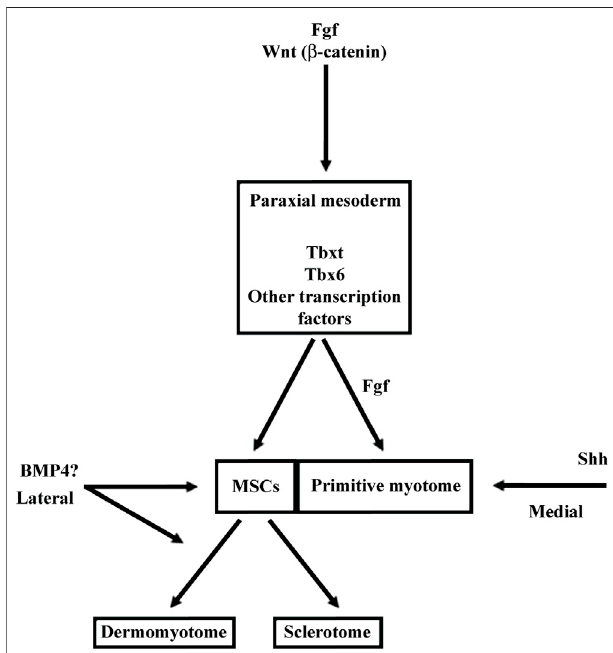
FIGURE 9 | The signaling pathways involved in MSCs and primitive myotome formation in Xenopus . In anamniotes and particularly in Xenopus , the somite development is characterized by the early and massive myotome formation, and the delayed sclerotome development. The construction ofprimitivemyotomeissoearlyspeci fi edthatitisinterconnectedtothedorso- mesoderm induction and the paraxial mesoderm speci fi cation. The signaling pathways like Fgf, Wnt and Nodal, involved in the dorso-mesoderm induction and in the paraxial mesoderm speci fi cation, also quickly trigger myogenic program leading to the primitive myotome formation (Jones et al., 1995; Wylie et al., 1996; Joseph and Melton, 1997; Fisher et al., 2002; Dorey and Amaya, 2010). In contrary, the amniote myotome formation takes place later after somitogenesis and the same signaling pathways involved earlier in the mesoderm induction and in the paraxial mesoderm speci fi cation did not induced myogenic program at the same time (Alev et al., 2013; Kiecker et al., 2016). In Xenopus , Fgf and Wnt play a key role in gene expression of the dorso-lateral marginal zone. This region can be considered as the presumptive paraxialmesoderm since itwillgive risetosomites later.Both Fgf and Wnt also contribute to the expression of Myf5 and Myod1 during the medial myogenic wave in Xenopus . Fgf has also been identi fi ed as the main inducer of the lateral myogenic wave which occurs later. In the beginning of neurulation, while the MSCs appear at the LSF, sonic hedgehog (Shh) secreted from notochord favors the myotome formation. BMP4 acts during neurulation to favor satellite cells lineage. Since the satellite cells are not already present at this stage, BMP4 would rather promote the MSCs and/or dermomyotome formation (Daughters et al.,